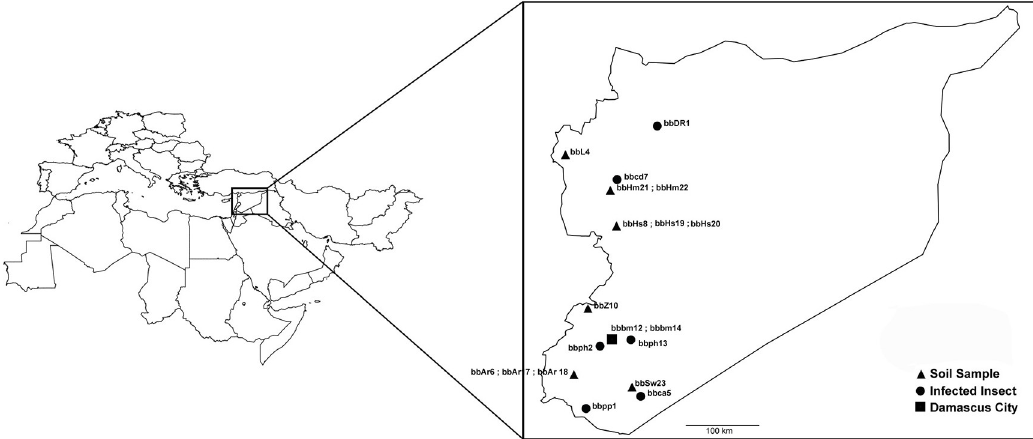
Fig 2. Geographical location of the area where the samples were collected. The inset shows the sampling sites distribution within the Syrian borders, the origin of the sample (soil or infected insects) and the code of the isolates. Maps were plotted by using the function map in the R package “maps” [28].